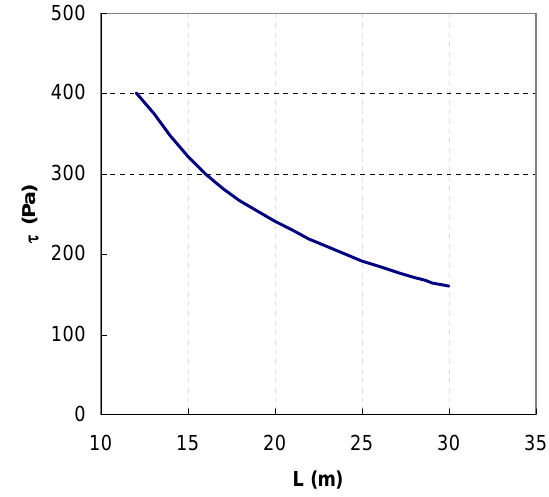
Fig. 18. Estimated hydraulic shear stress in a cylindrical pipe as a Figure 18 – Estimated hydraulic shear stress in a cylindrical pipe as a function of the pipe 5 function of the pipe length (pipe diameter of D = 0.5m; water head loss of H f =